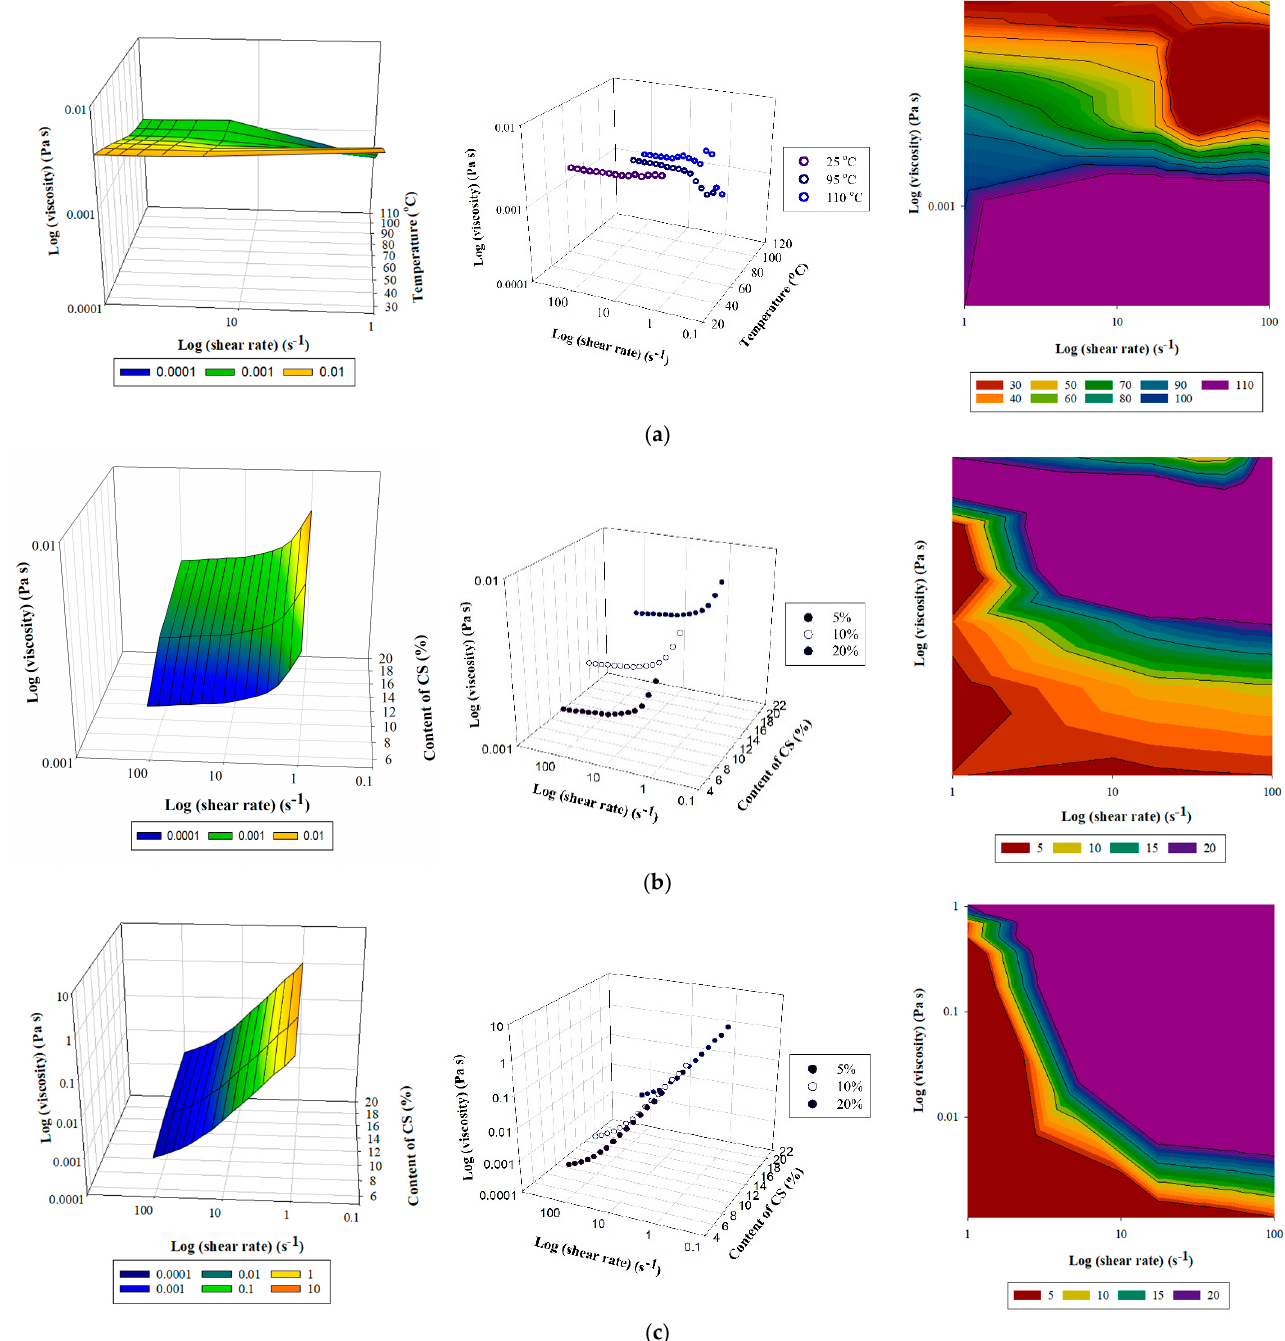
Figure 4. ( a ) Viscosity curves of pure electrolyte; ( b ) viscosity curves of electrolyte with CS additive at 25 °C; ( c ) viscosity curves of electrolyte with CS additive at 95°.